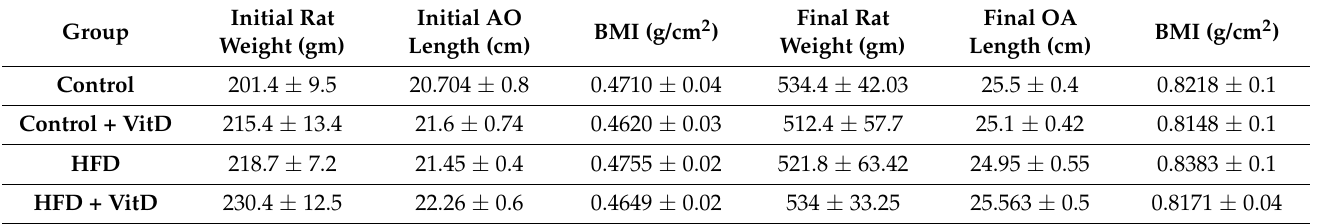
Table 3. Initial and final body weight, oral to anus (OA) length, and body mass index (BMI) after 6